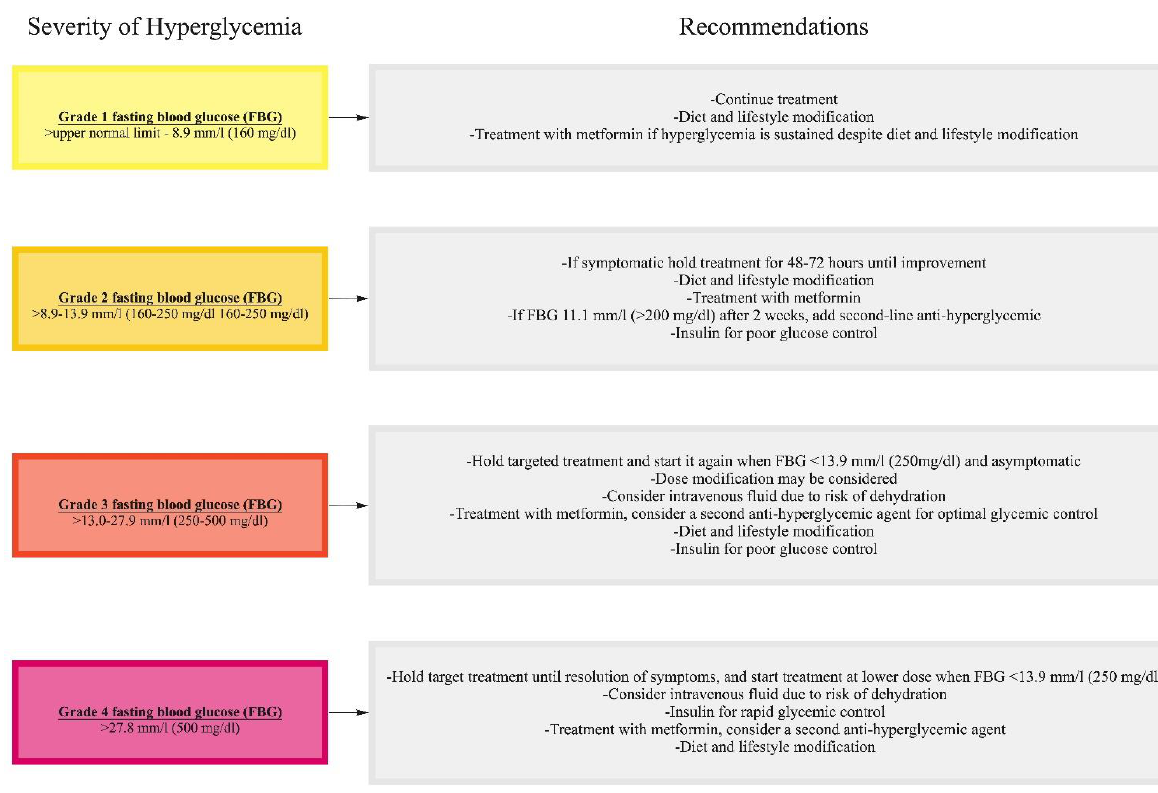
Figure 1. Management of targeted treatment-related hyperglycemia.